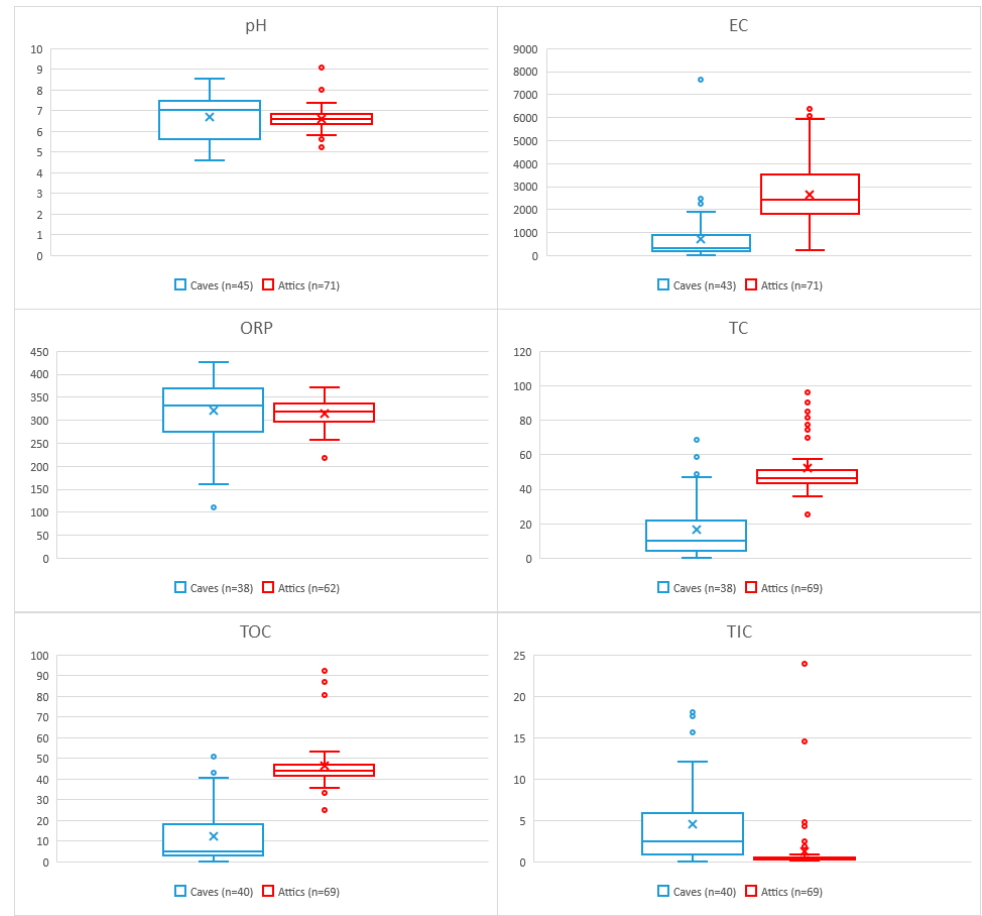
Figure 4. Box plot with Physico-chemical parameters of bat guano samples. Figure interpretation. × corresponds to the arithmetic mean; the rectangle indicates the area between the upper and lower quartiles; the horizontal line indicates the median, and the vertical lines plus points (outlier values) indicate the range of values; EC = Electrical Conductivity ( µ S/cm); ORP = Oxidation-Reduction Potential (mV H ); TC = Total Carbon (%); TOC = Total Organic Carbon (%); TIC = Total Inorganic Carbon (%); n = Number of examined samples.